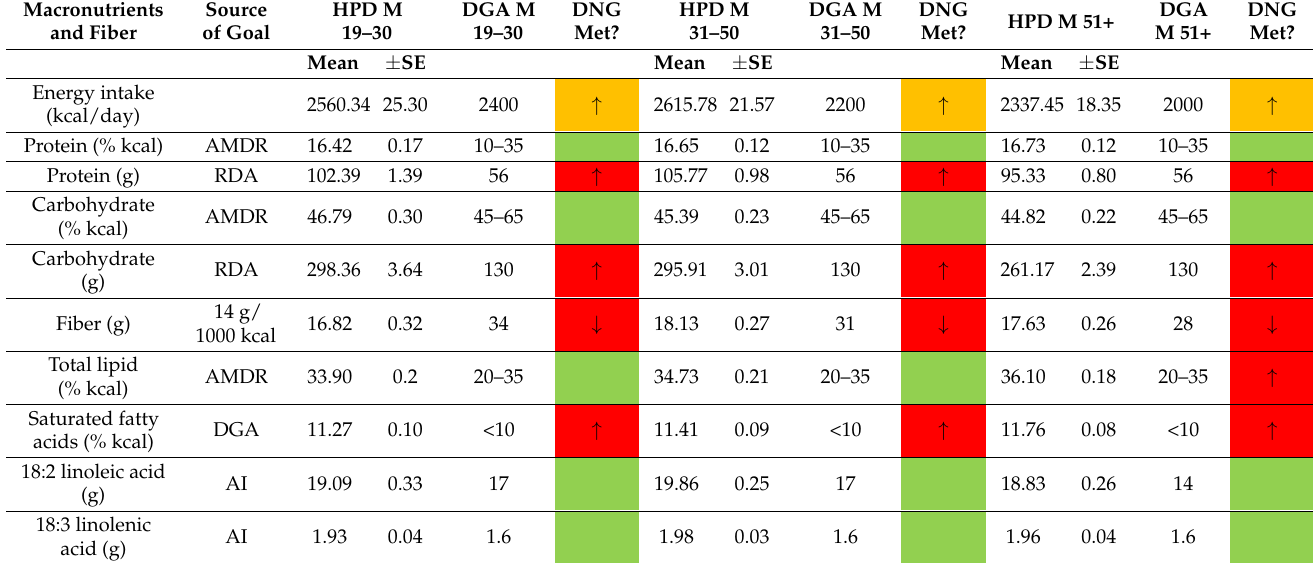
Table 4. Macronutrient and fiber intake in males following an HPD compared to the DNG in the 2020–2025 DGA stratified by age group.